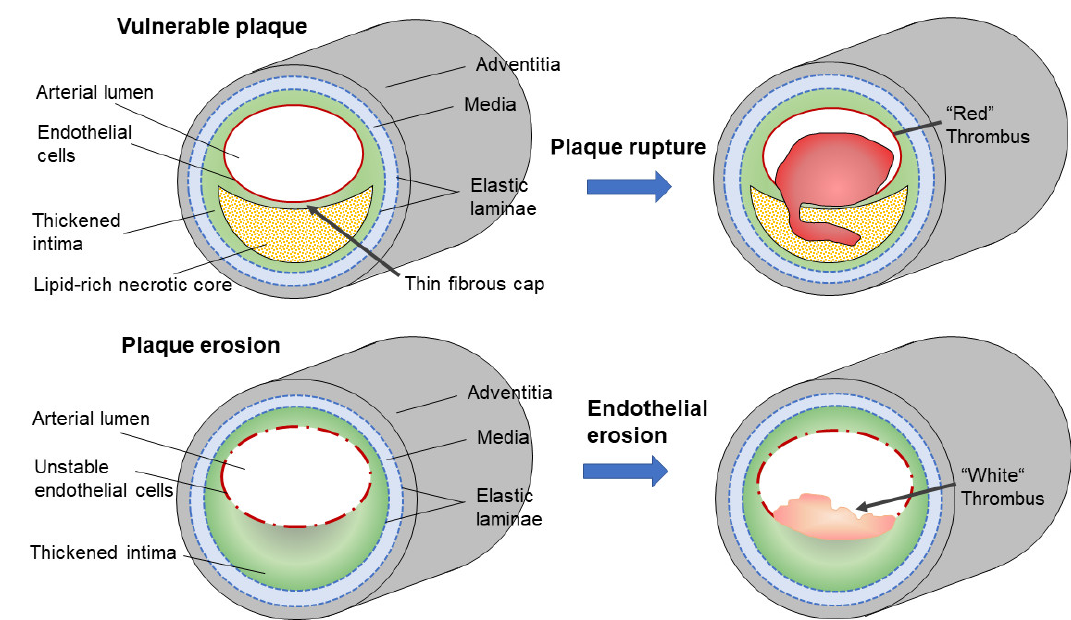
Figure 1. Two types of culprit lesions responsible for vascular events. Vulnerable plaque is characterized by a necrotic core, which accumulates a large amount of lipids covered with a thin “fibrous cap”. Inflammatory responses render the fibrous cap fragile and lead to plaque rupture. Once the fibrous cap is broken, a rapid formation of thrombus and fibrin occurs, and a red thrombus is formed. Plaque erosion, also called superficial erosion, is characterized by a thickened intima enriched in glycosaminoglycans, but with less lipid accumulation. Inflammatory responses make the endothelial cells unstable and lead to detachment of the cells. After the endothelial cells are lost, thrombus formation occurs, and a white thrombus is formed.